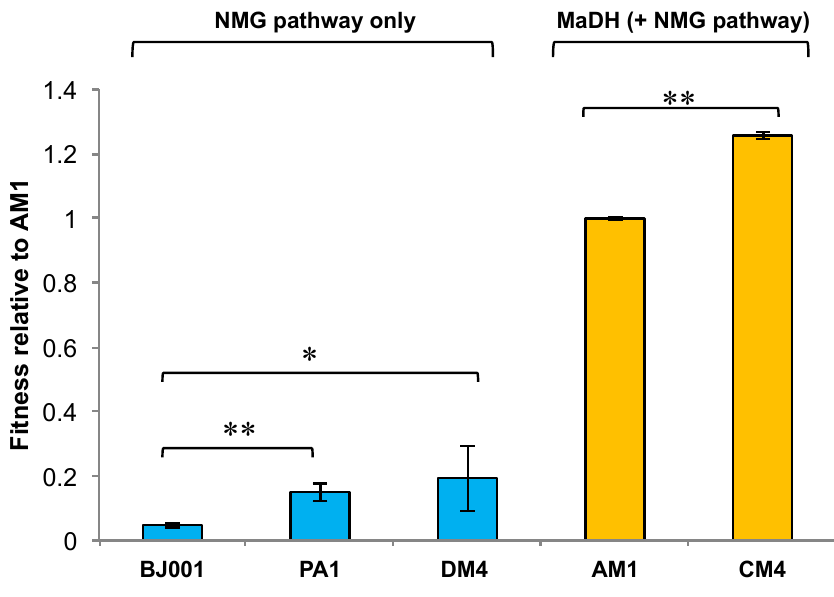
Figure 5. Methylamine fitness of M. extorquens species relative to AM1 . Strains that use the N- methylglutamate pathway are depicted in blue and strains that use methylamine dehydrogenase (but also contain the N- methylglutamate pathway) are depicted in orange. Error bars depict the 95% confidence interval (C.I.) of the mean relative fitness determined by three replicate competition assays. ** p < 0.01 and * p < 0.05 for a significant difference in fitness on